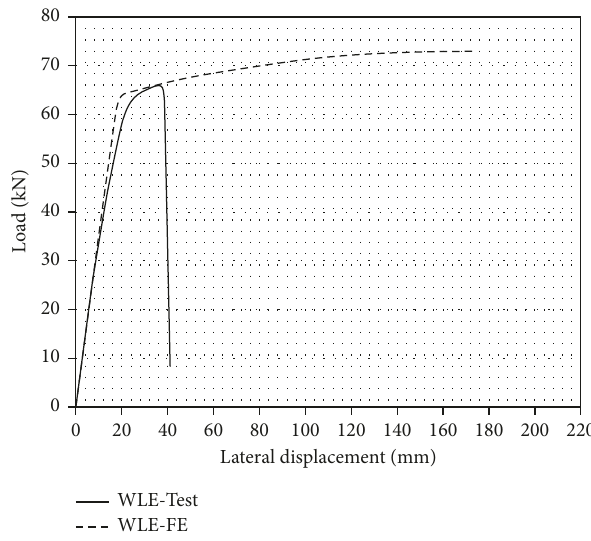
Figure 10: Load-deflection verification curve of test versus FE (specimen WLE).